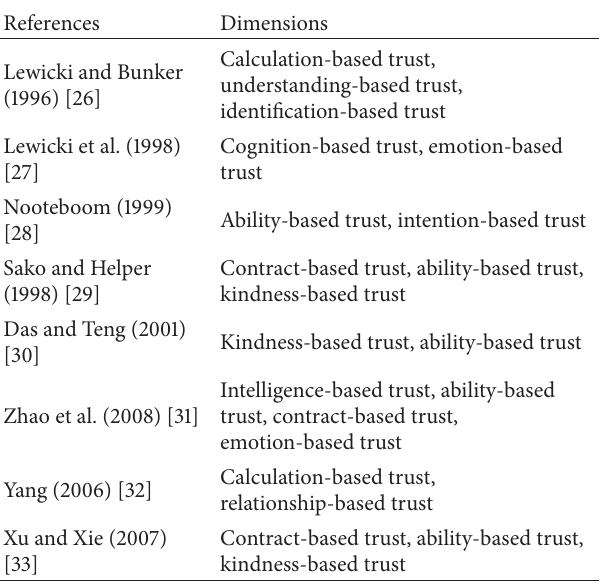
Table 1: The dimensions of